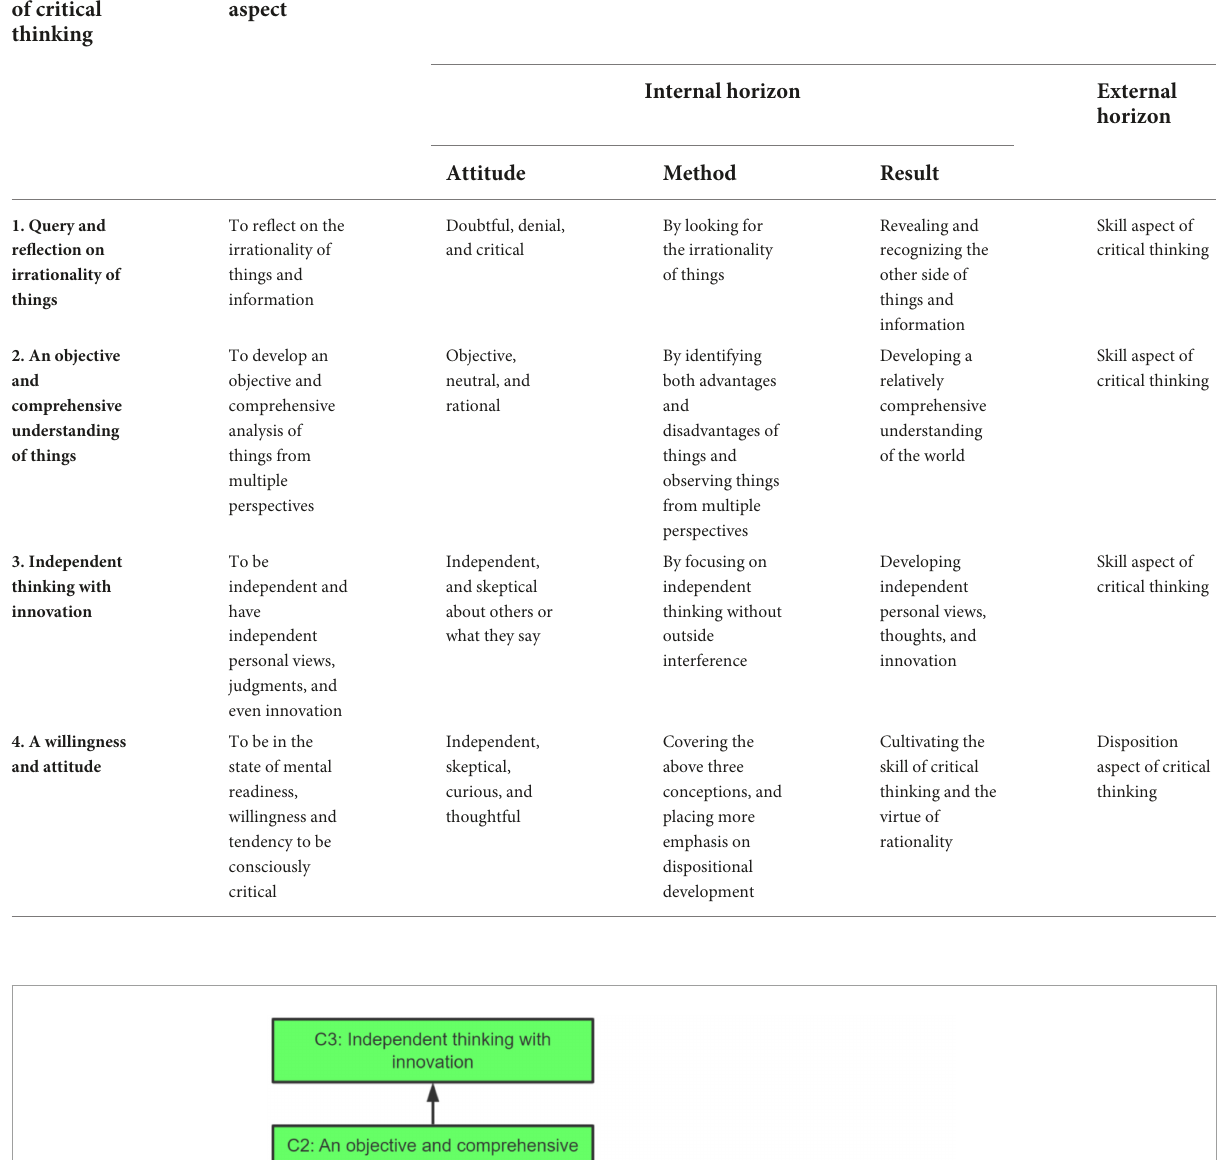
TABLE 2 Critical thinking in the “referential-structural” analytical framework.